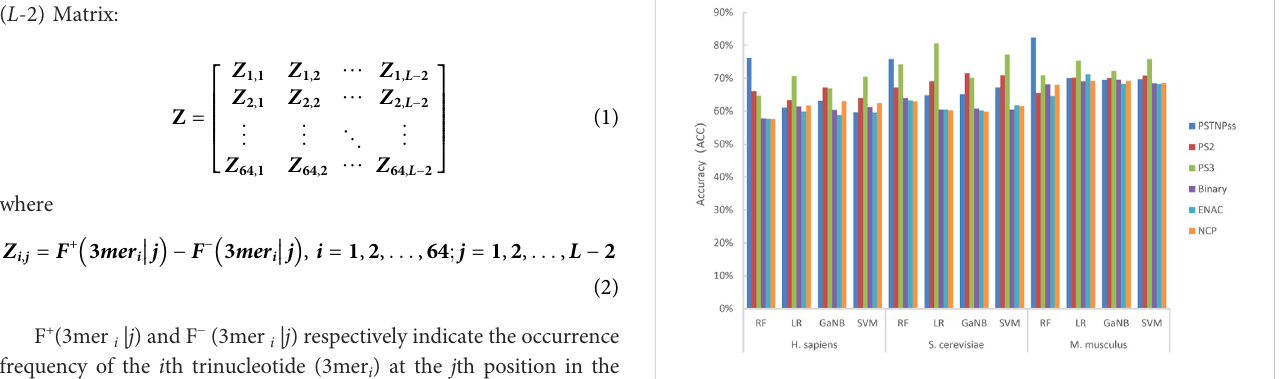
FIGURE 2 Theaccuracyofthefourmodelstrainedusingthebestsixencoding schemes for H. sapiens , S. cerevisiae , and M. musculus